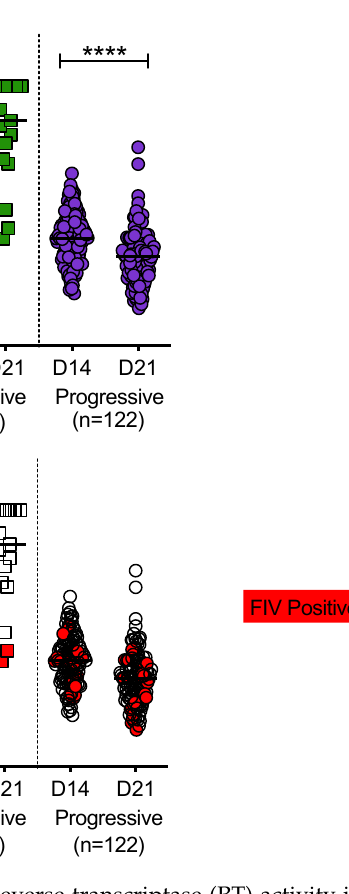
Figure 10. PBMC culture fluid reverse transcriptase (RT) activity in different exposure outcome groups ( a ) Detection of RT in PBMC culture fluids collected on day 14 (D14) and day 21 (D21) following in vitro culture of PBMC. No RT was detected in culture fluids from uninfected cats. ( b ) The FIV status was known for all cats tested. Samples testing positive for FIV antibodies using IDEXX SNAP ® FIV/FeLV Combo Test are highlighted in red. Statistical significance was determined using the Wilcoxon matched-pairs signed rank test ( p -value < 0.0001 ****). PBMC culture fluids (from D14 and D21 of culture) were tested for p27 capsid anti- gen, Figure 11. PBMC culture fluids from uninfected cats tested negative for p27 capsid antigen. All PBMC culture fluid samples from discordant cats and cats with regressive infection tested negative for p27 capsid antigen; with the exception of three D14 discord- ant PBMC culture fluid samples and one D14 PBMC culture fluid sample from a cat with regressive infection. A range of p27 capsid antigen concentrations were detected in PBMC culture fluids from cats with progressive infection (absorbance values at 650 nm ranged from 0 to 3.23). Not all PBMC culture fluid samples from cats with progressive infection contained detectable levels of p27 capsid antigen. In general, the concentrations of p27 capsid antigen in D21 culture fluids were lower than those measured in D14 culture fluids (the converse was true for RT detection). This decrease was statistically significant in the discordant and progressive outcome groups. All of the D21 culture fluids that tested pos- itive were confirmed using the IDEXX FeLV PetChek ® ELISA neutralisation protocol, as were outlier samples (denoted as a, b, c and d). Outlier samples ‘b’ and ‘d’ also tested positive for RT. Figure 11. PBMC culture fluid p27 capsid antigen detection in different exposure outcome groups. PBMC culture fluids collected on day 14 (D14) and day 21 (D21) of PBMC in vitro culture were tested for p27 capsid antigen using the IDEXX PetChek ® ELISA and p27 antigen concentrations (absorbance values, A 650 ) are shown. Samples a, b, c and d were outlier samples that tested p27 capsid antigen positive. Statistical significance was determined using Wilcoxon matched-pairs signed rank test ( p -value < 0.05 * and < 0.0001 ****).